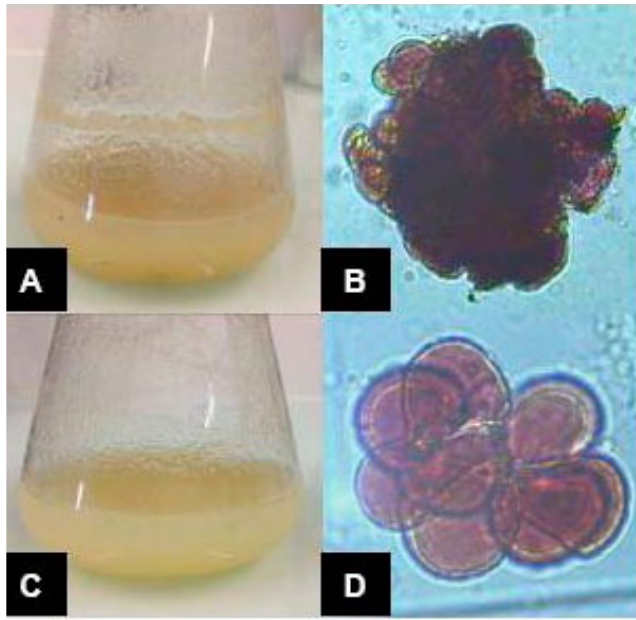
Fig. 2 - Establishment of Cakile maritima cell suspensions. (A) Dense suspension cells grown in flask after two months feeding and (B) corresponding cell aggregates magnified 385X. (C) Dense sus- pension cells grown in flask after 1.5 months of subculture after feeding and (D) corresponding cell aggregates magnified 385X.